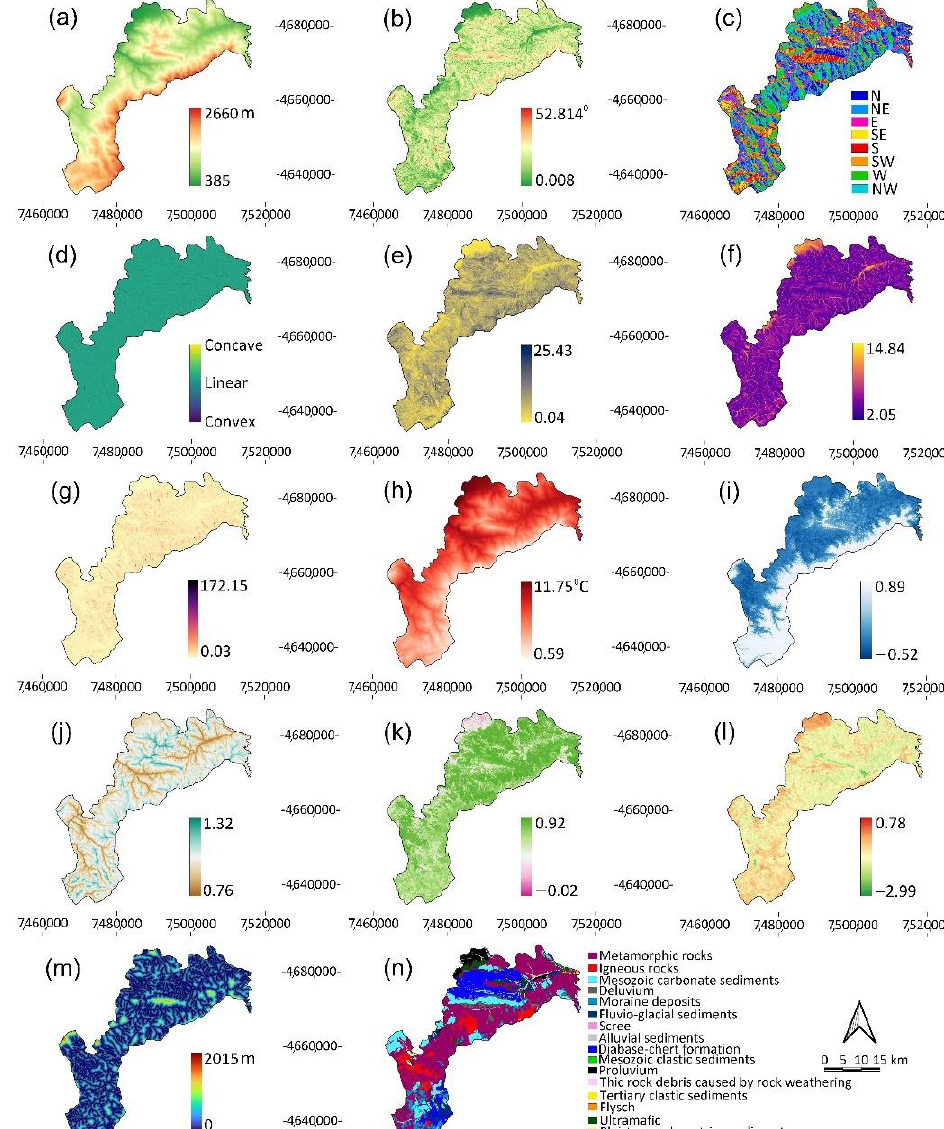
Table 7. Assessment of geomorphological conditions .